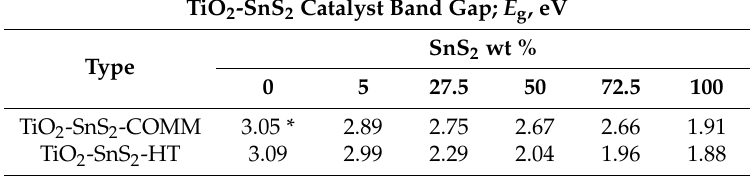
Table 2. Band gap values of TiO 2 -SnS 2 -COMM and TiO 2 -SnS 2 -HT in the dependence to SnS 2 wt % within